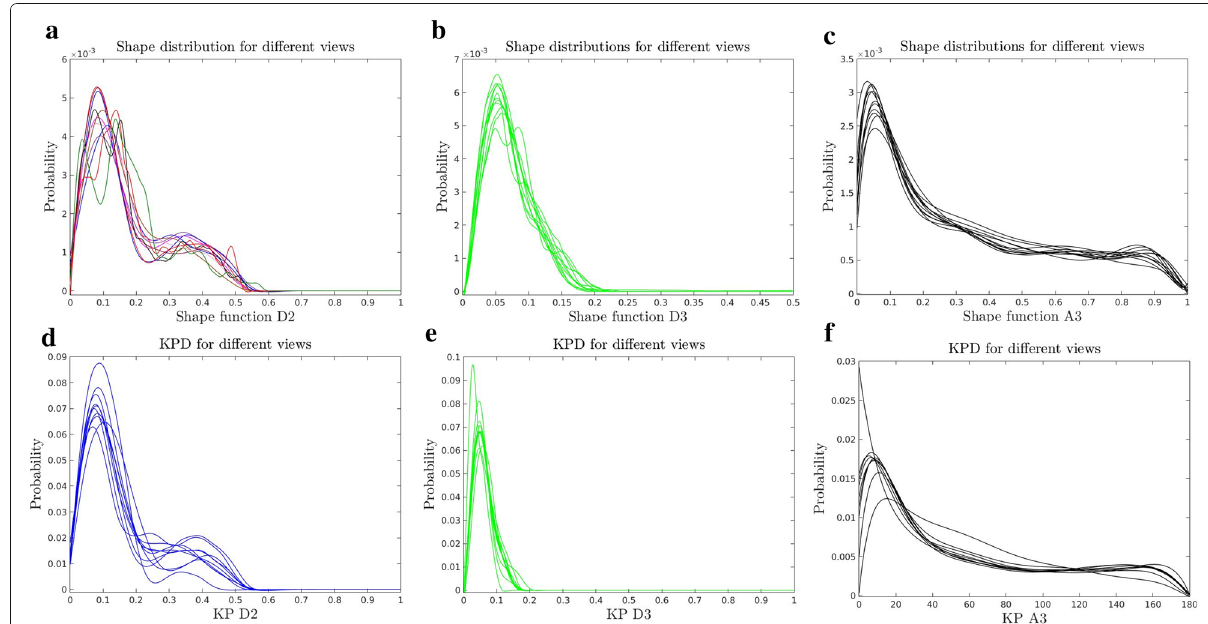
Fig. 15 Shape distributions and KPD’s of multiple views of guitar (taken at 0°, 5°, 10°, 15°, 20°, 25°, 30°, 35°, 40°, 45°). It can be seen that KPD-D2’s and KPD-D3’s PDF are consistent across pose changes, whereas D2 and D3 have changed their form with pose change of the object